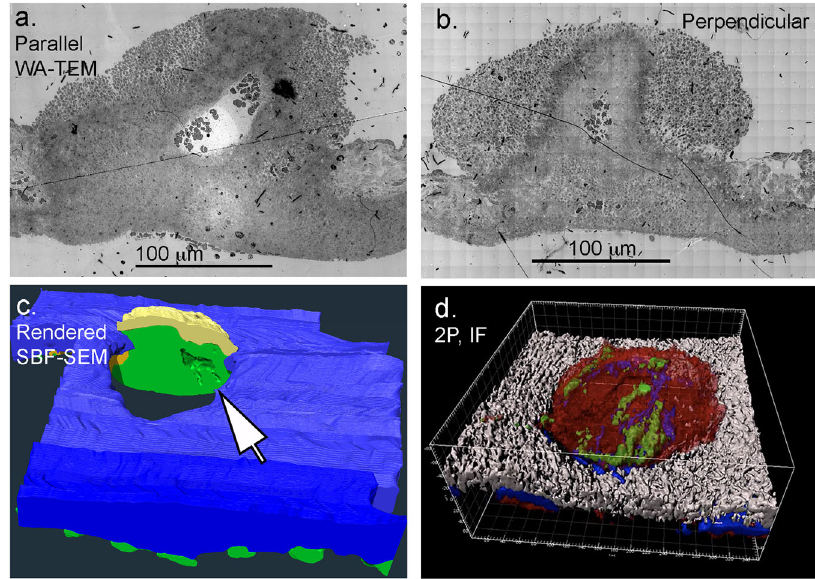
Fig. 6 Thrombus remodeling leads to the retention of vaulting in 20 min thrombi. The central portion of the thrombi appears to contain a “ compressed ” zone of tightly adherent platelets. a / b wide area TEM images of 20 min post wounding jugular thrombi taken either parallel to fl ow or perpendicular to fl ow. Note that the parallel image appears shaped by fl ow while the perpendicular to fl ow image appears to be nearly symmetric with respect to left and right. c A split open 3D rendering from SBF-SEM imaging of a 20 min post puncture thrombus (representative example, n = 2, SBF-SEM image sets) showing that the limited vaulting in the thrombus is enclosed by tightly adherent platelets. Tightly adherent platelets (green), loosely adherent platelets (yellow), vessel wall (blue). Note that extravascular platelet accumulation is found in hundreds of microns from the ~200 μ m diameter puncture hole. d 2P, immuno fl uorescence rendering of protein distributions within a representative 20 min thrombus. Platelets (red, CD41), mobilized/exposed p-selectin (green), fi brin (blue), vessel wall (white). Note that fi brin staining “ bands ” within the intravascular interior of the thrombus appear to be in proximity to parallel bands of mobilized/exposed p-selectin staining. WA-TEM, wide area transmission electron microscopy. SBF-SEM, serial block face scanning electron microscopy. If, immuno fl